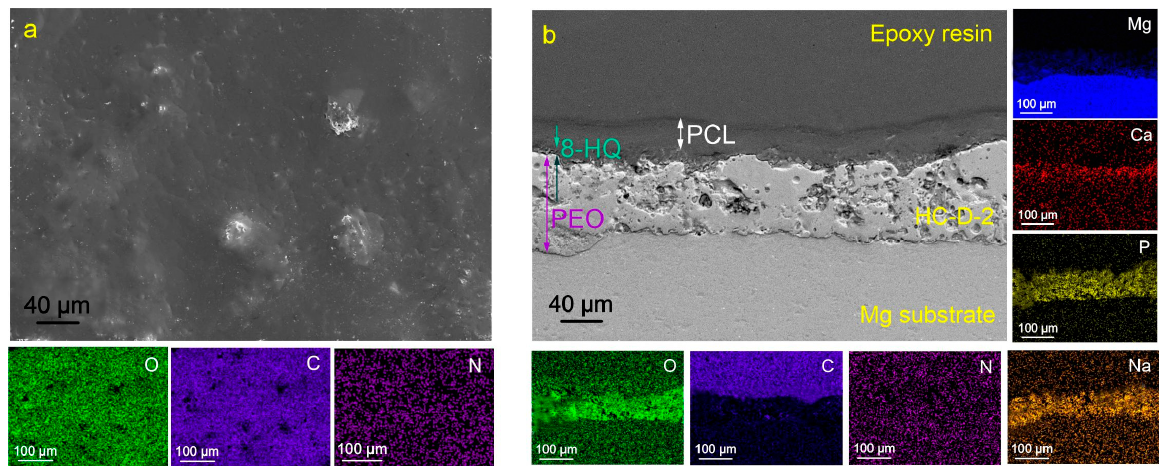
Figure 4. SEM images of the surface ( a ) and cross-section ( b ) of the HC-D-2-coated samples and maps of elements distribution over the sample’s surface ( a ) and thickness ( b ).